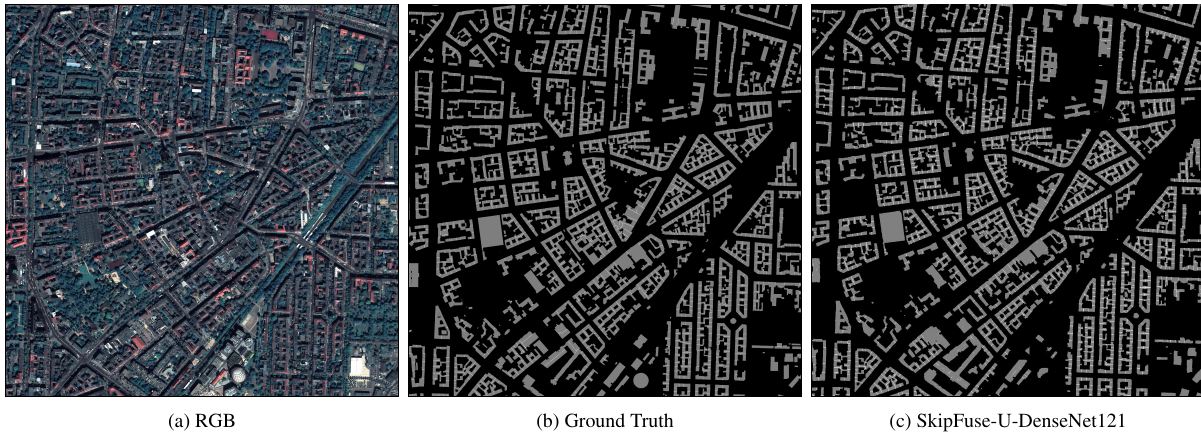
Figure 4. Whole test set, with (a) RGB, (b) GT and (c) output from SkipFuse-U-DenseNet121. Best viewed zoomed-in on a computer